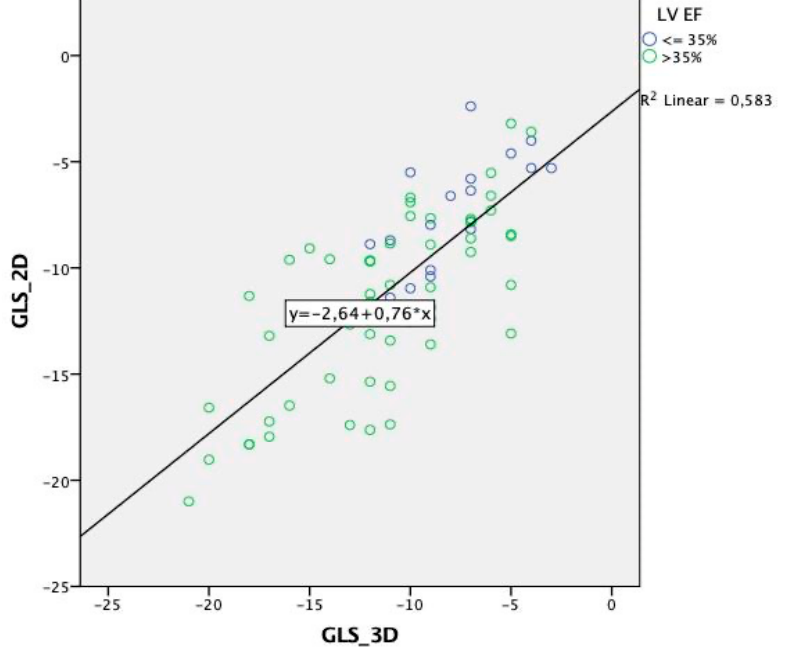
Figure 6. Scatter plot of 2D vs. 3D global longitudinal strain sorted by left ventricular ejection fraction (LV EF) with displayed regression equation.